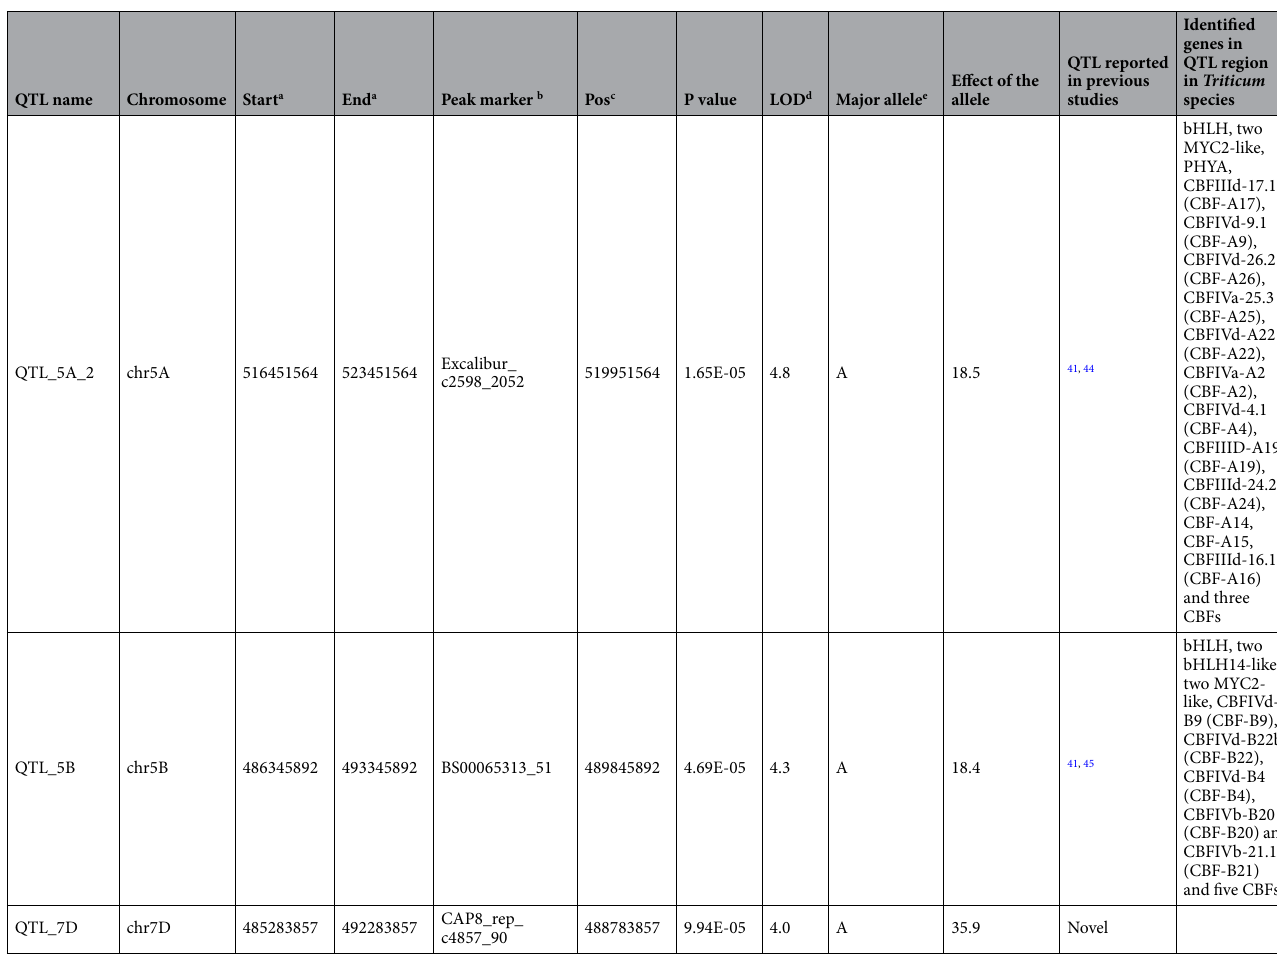
Table 1. QTL regions associated with FroT in wheat (LOD ≥ 4). a Start and End position of the QTL interval. b Name of the Peak marker. c Position of the Peak marker. d -Log10 of p value (LOD). e Major allele that influence